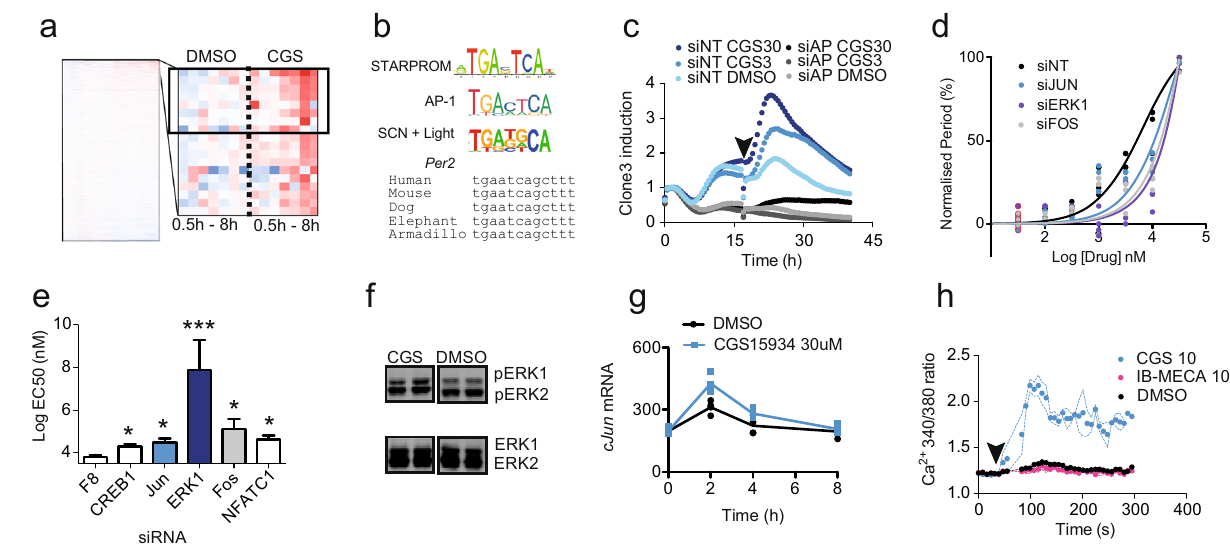
Fig. 2 STAR_PROM identi fi es ERK-AP1 pathway downstream of adenosine signalling. a Time course of RNA-seq reads for barcoded luciferase from BC- STARPROM reporter transfected U2OS cells treated with DMSO control or 30 μ M CGS ( n = 2, timeline – 0, 0.5, 1, 2, 4 and 8h after treatment). The enlarged cluster shows the top 20 upregulated clones, of which 8 were statistically signi fi cant (boxed, p <0.05, two-way ANOVA). b Consensus sequence from the upregulated clones with the consensus AP-1 RE and the light-regulated SCN transcriptome motif shown for comparison. The conservation of the AP-1 RE in the PER2 gene is indicated, genomic position 2:238287740 (hg38) in humans and 1:91458384 (mm9) in mice. c Reporter activity of clone3 after knockdown of FOS and JUN (siAP1 – grey) when compared with a non-targeting siRNA control (siNT – blue) in response to CGS (30 μ M – C30, 3 μ M – C3 or DMSO, n = 4, single trace shown for clarity). d , e Concentration response curves and EC 50 of CGS-mediated period lengthening in Per2 -Luc U2OS cells after knockdown of the genes indicated ( n = 4, DMSO controls outlined in red * = p <0.05, *** = p <0.001 One-way ANOVA, Bonferroni post-hoc test); EC50 error calculated from raw data in (n). f Increased phosphorylation of ERK1/2 (pT202/Y204 – pERK) with 30 μ M CGS treatment in U2OS cells (48%±18% increase, p = 0.03, n = 3 to 6, one- way ANOVA, Tukey ’ s post-hoc test). g c JUN mRNA increases after treatment with 30 μ M CGS – C30 ( n = 4, ** = p <0.0021 at 2h, Š ídák ’ s multiple indicate range of data. Individual data points overlaid on all charts with line representing mean, unless otherwise indicated, error bars =